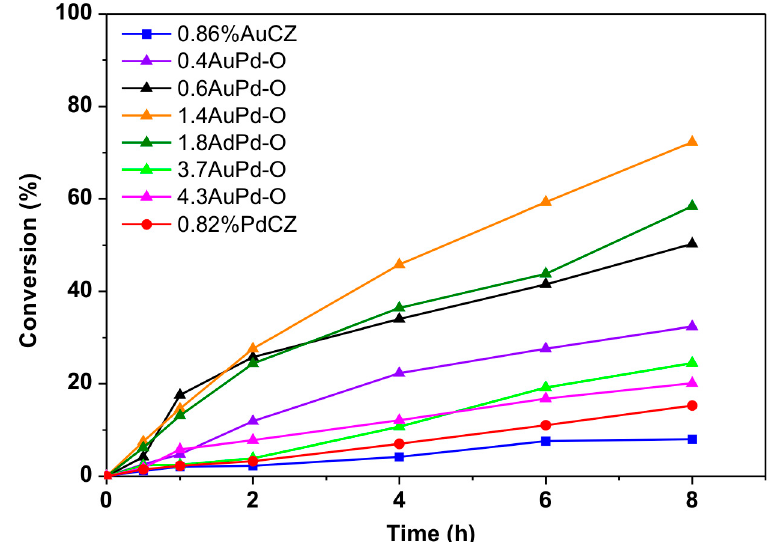
Figure 6. Catalytic activities of veratryl alcohol oxidation in the liquid phase as a function of time in the presence of the monometallic or bimetallic catalysts. Reaction conditions: alcohol:total metal ratio = 1000 mol:mol, alcohol 0.3 M, reaction temperature: 80 °C. The reactor was pressurized at 200 kPa of oxygen.